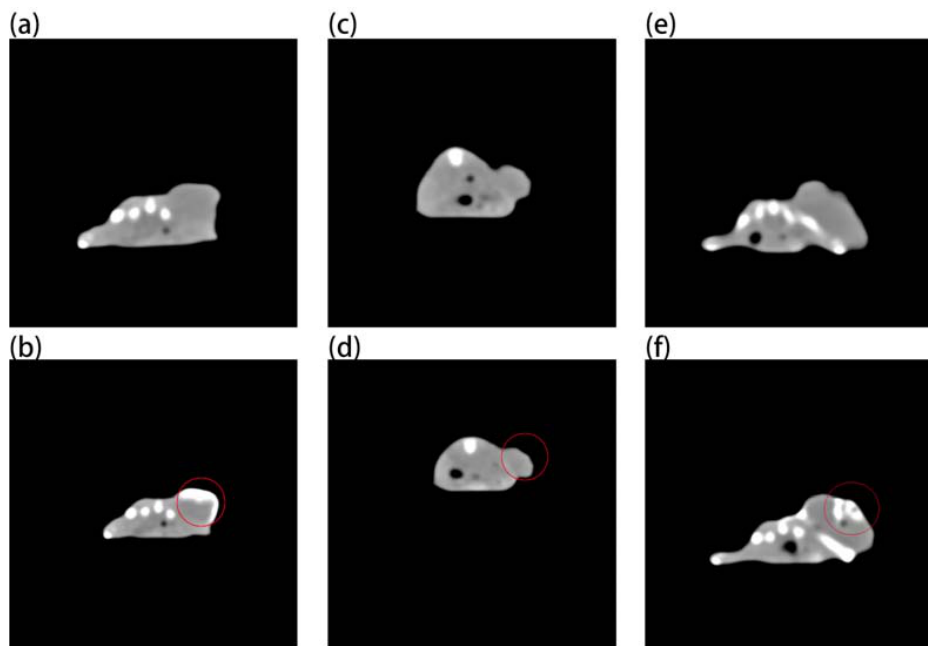
Figure 7. Micro-CT images before and after intratumor injection of Au and Au-UCNPs-DSPE-PEG 2K in Balb/c mice, ( a , b ) are before and after injection of high concentration (50 mg/mL) of Au, ( c , d ) are before and after injection of low concentration (180 µ g/mL) of Au, ( e , f ) are before and after injection of 180 µ g/mL of Au-UCNPs-DSPE-PEG 2K .